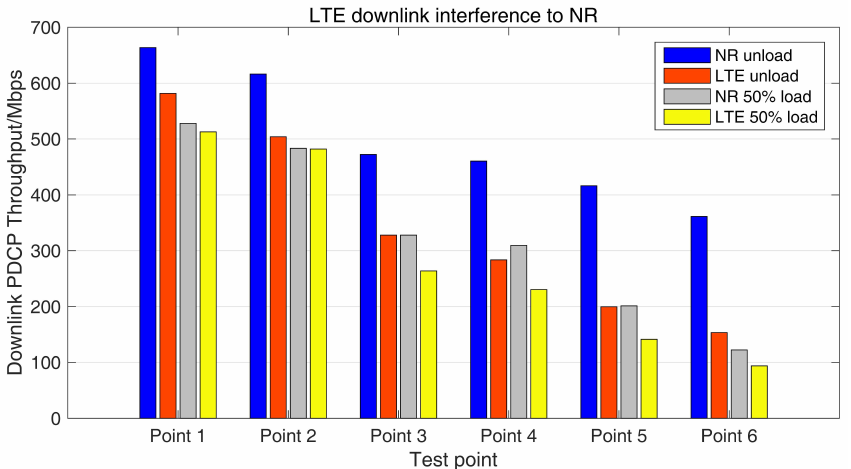
Figure 14. LTE to NR downlink interference test